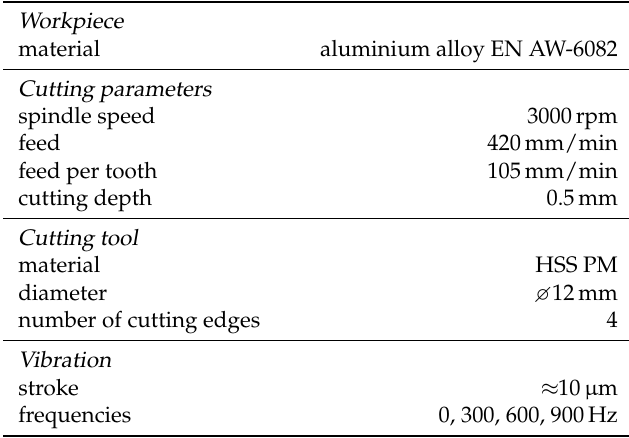
Table A1. Machining parameters for the first milling trials.